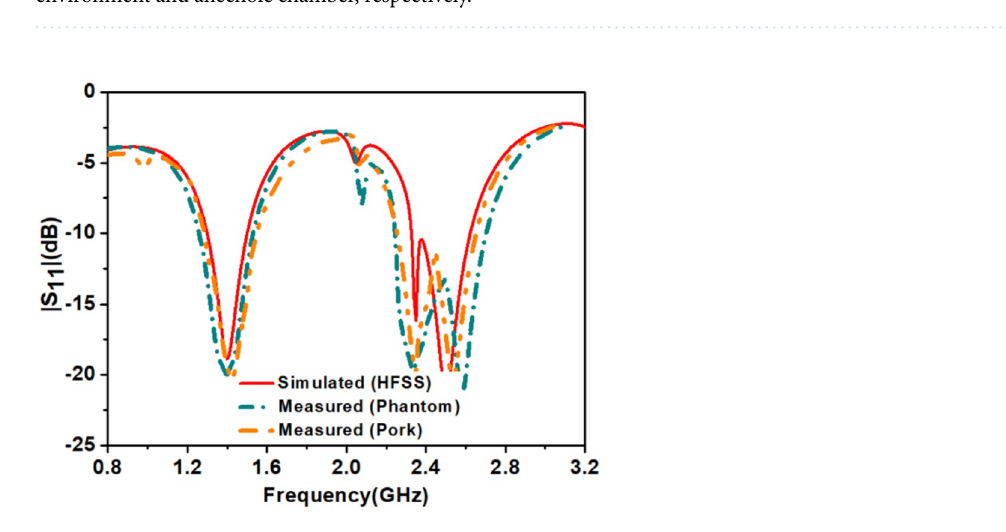
Figure 18. Near-field and far-field measurement set-up for the proposed integrated antenna in open lab environment and anechoic chamber, respectively.